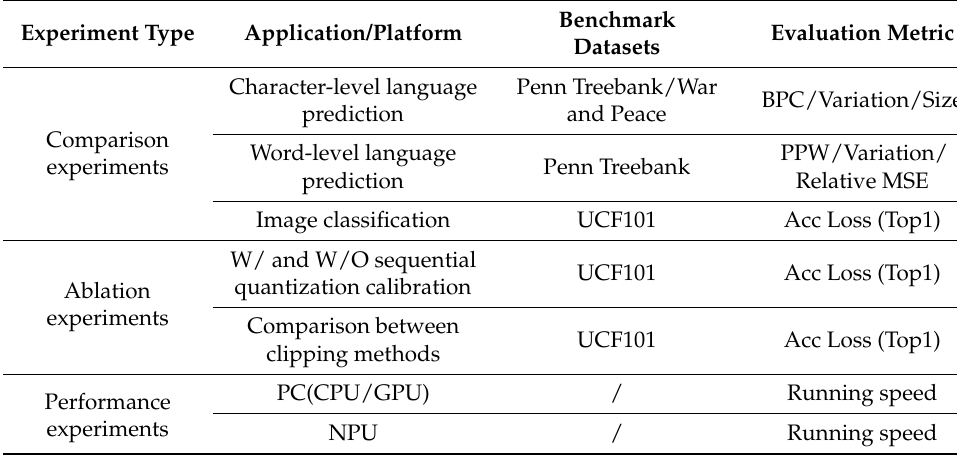
Table 2. Experimental settings and evaluation